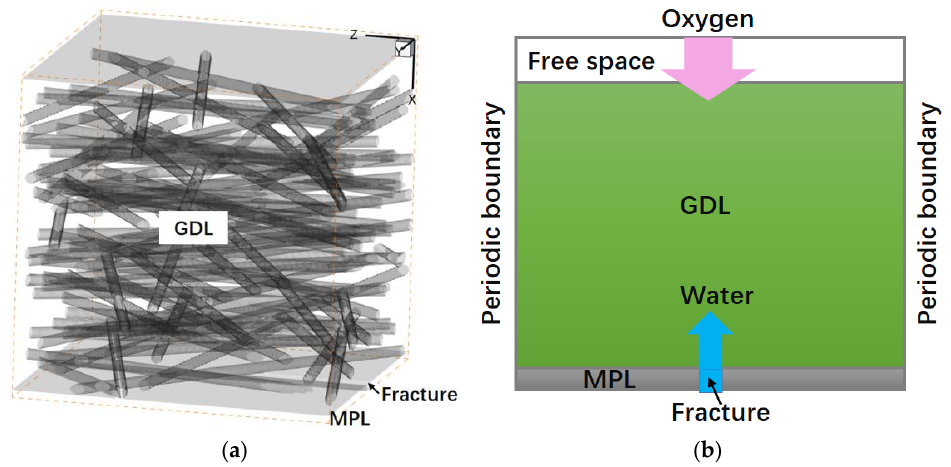
Figure 2. Computational domain ( a ) 3D structure and ( b ) schematic of the oxygen and water transport processes in the domain.